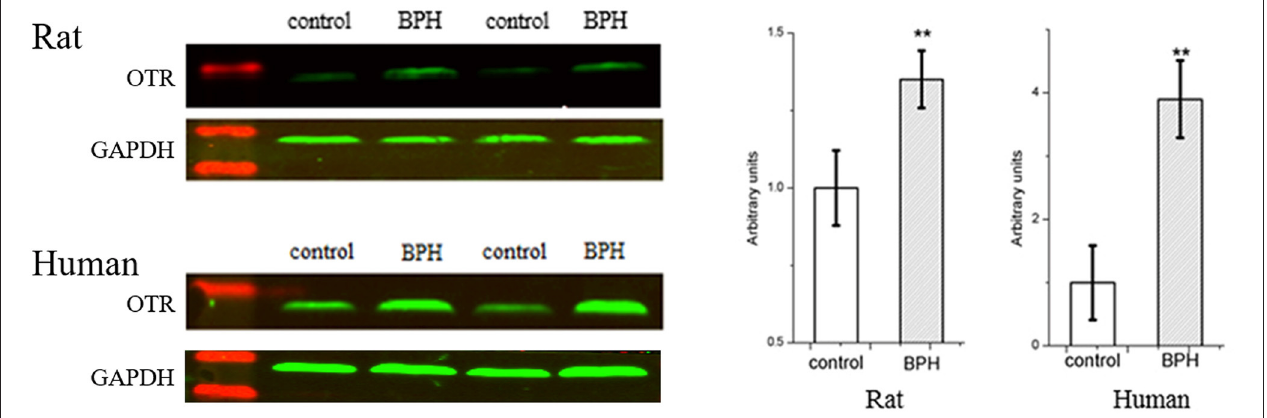
FIGURE 10 | Left : Representative Western Blot bands of rat and human prostate. Two major specific bands of the expected sizes (37 (GAPDH) and 43 (OTR) kDa, green) are evident in all lanes, red bands indicate the protein markers. Right : Relative densitometric quantification of OTR in rat and human prostate. GAPDH expression was analyzed as a loading control, results are expressed as ratio of OTR to GAPDH. Boxes, mean; bars, ± S.E.M; ** P < 0.01 vs.